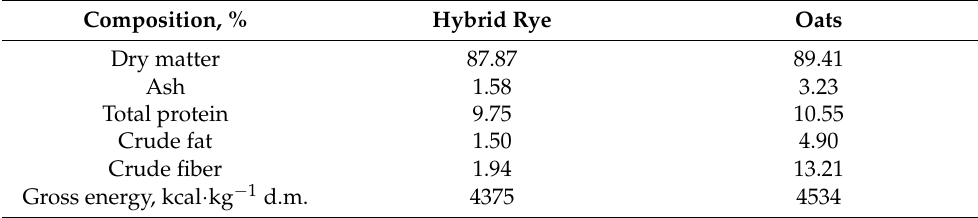
Table 3. Chemical composition of hybrid rye and oats used for geese feeding after 98 days of